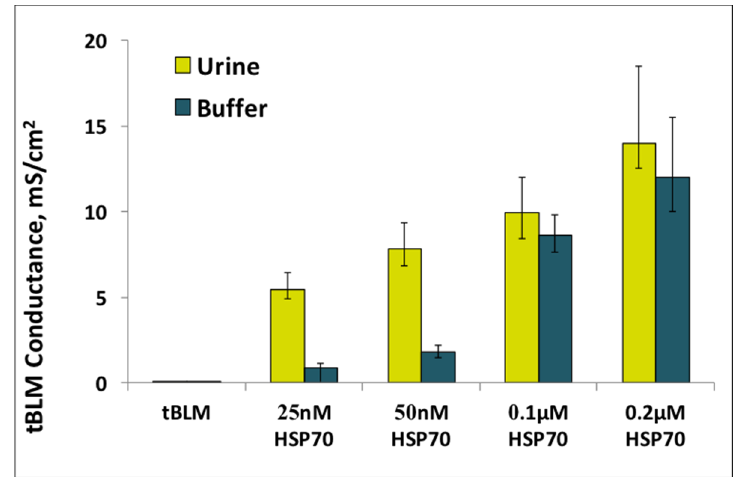
Figure 7. The effect of HSP70 on the conductance of BLMs, composed from DOPC: CHO (in ratio % 60:40) phospholipid mixture, as a function of protein concentration in urine (yellow) and buffer (teal) in range from 25 nM to 0.2 μ M. The spectra were measured 10 min after the addition of HSP70 to final concentration.